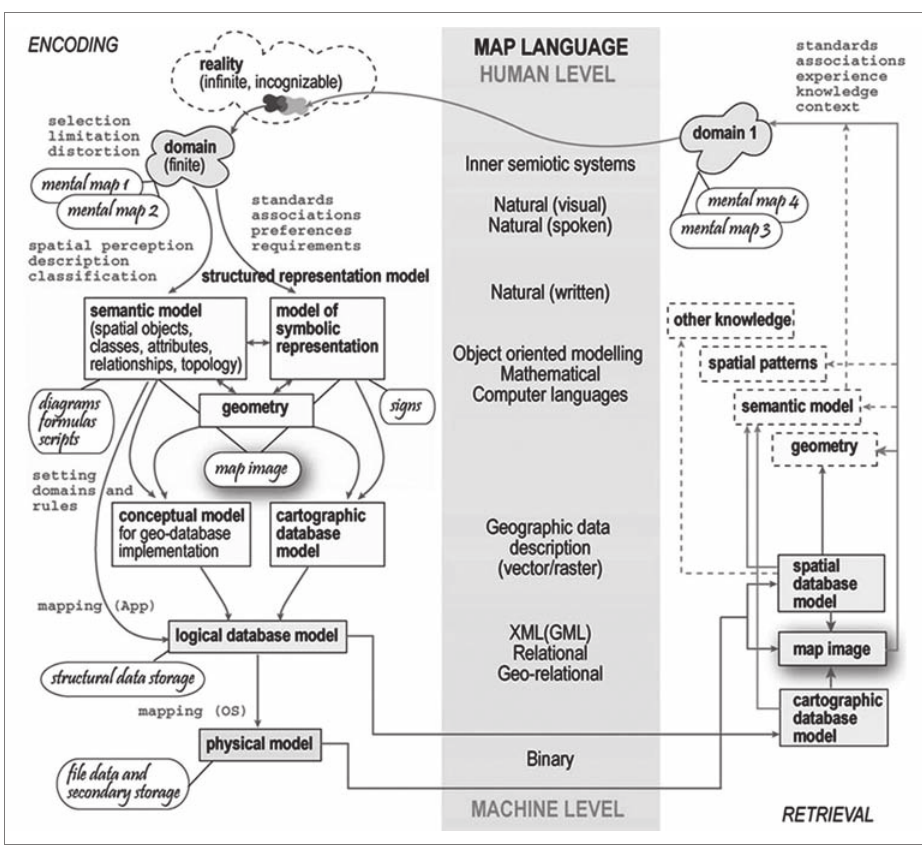
Fig. 3. Scheme of cartographic